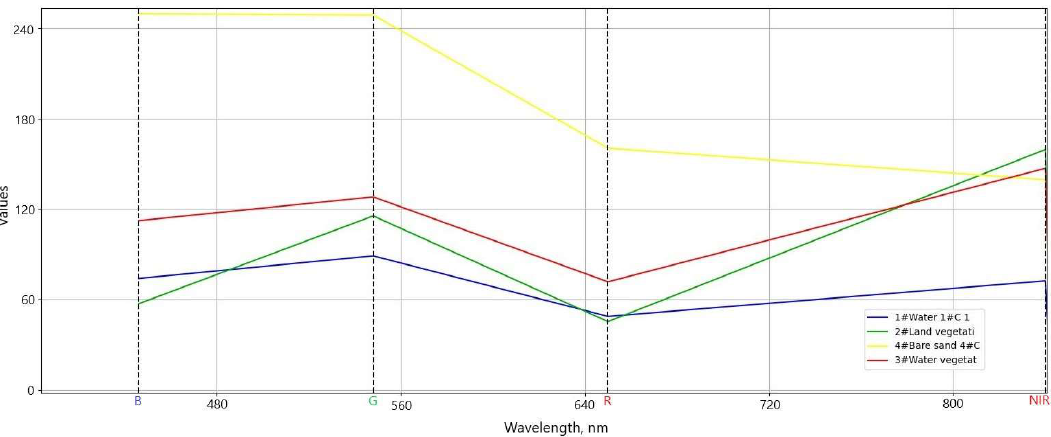
Figure 8. Spectral signatures of different surfaces: water, sand, land, and water vegetation. Judging from the graph, sand produced the highest reflection of blue, green, and red. This is expected because it is a light color, i.e., it reflects the light the best and the values in the range of NIR are lower, because NIR is absorbed by the sand. Water reflects light in the blue and green spectrums the most. In the summertime, water in the Kaunas HPP reservoir has a light green tint and the NIR spectrum reflectance is lowest out of all of the analyzed areas, because water absorbs the NIR the most. The reflectance in the near-infrared region of the electromagnetic spectrum suggests that the water may have contained a small amount of algae. The most important part of this analysis was the comparison of land and water vegetation. It is visible in the diagram that overall water vegetation had a higher reflectance in the RGB range, with the largest difference being noticeable in the blue spectrum. Some yellow reeds made up the water macrophytes; for this reason, red and blue reflectance was higher as compared to the land vegetation. The NIR reflectance was quite similar for land and water vegetation, with the land vegetation reflecting the NIR a little more, because it was denser in general. A statistical analysis of the spectral reflectance of land and water vegetation was performed for further investigation (Table 3). Table 3. Statistical analysis of the spectral reflectance of land and water vegetation. Wavelength, nm